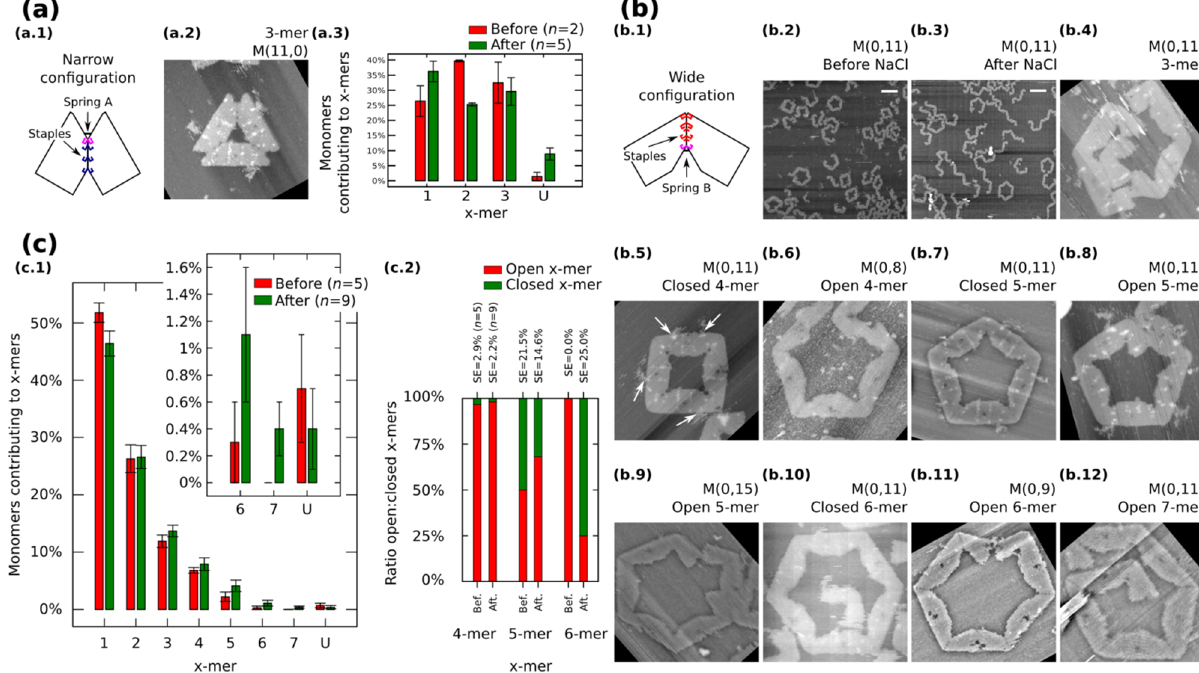
Figure 3. Self-assemble and reconfiguration of fixed monomers. ( a.1 ) and ( b.1 ): Fixed monomers. ( a.2–3 ) 3-mers and cluster distribution before and after reconfiguration of M (11,0). ( b.2–3 ) Representative AFM images of M (0,11) before and after reconfiguration. ( b.4–12 ) Clusters after reconfiguration for different spring B. White arrows in ( b.5 ) show extra M13. ( c ): Distribution of monomers contributing to the formation of x -mers including open and closed states ( c.1 ) and ratio open:closed x -mers ( c.2 ) for M (0,11). U indicates unclear monomers. AFM images are 310 nm × 300 nm. Width of ( b.9 ) is 500 nm. Scale bars are 200 nm. Error bars in ( a.3, c.1 ) and SE in ( c.2 ) indicate the standard error. n indicates the number of analysed AFM images of 2040 nm × 1680 nm, and the number of counted monomers per each AFM image is shown in Figure